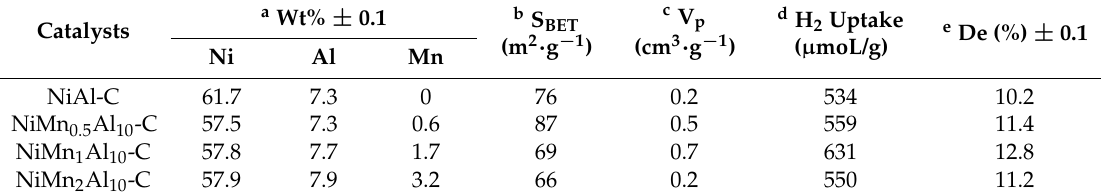
Figure 3. N 2 -adsorpotion/desoportion isotherms ( a ) and pore size distribution of catalysts ( b ). Table 2. Physicochemical property of catalysts.